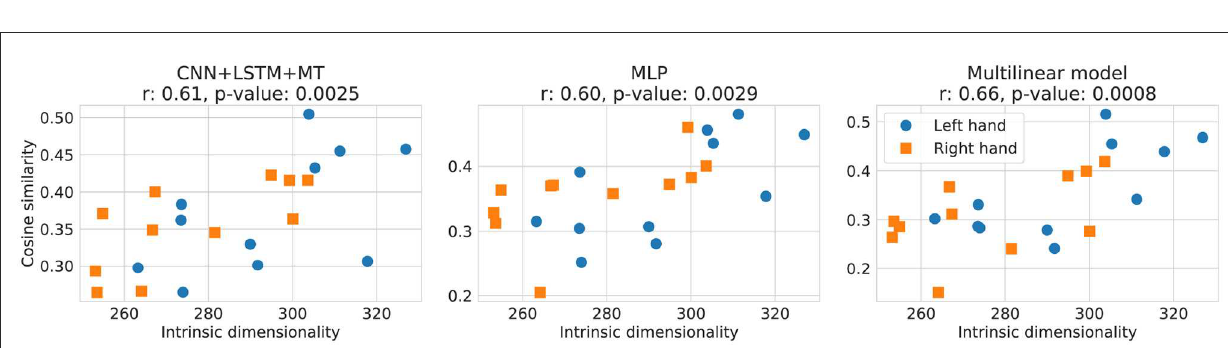
FIGURE9 Relationship between cosine similarity and local ID of the training dataset computed with ESS for dataset translation experiment. In the plot titles, Pearson correlation coefficient r and p -value (the probability of two uncorrelated inputs obtaining r at least as extreme as obtained in this case) are presented. Cosine similarity of 3D translation decoding for the left and the right hands is shown by blue and orange respectively.